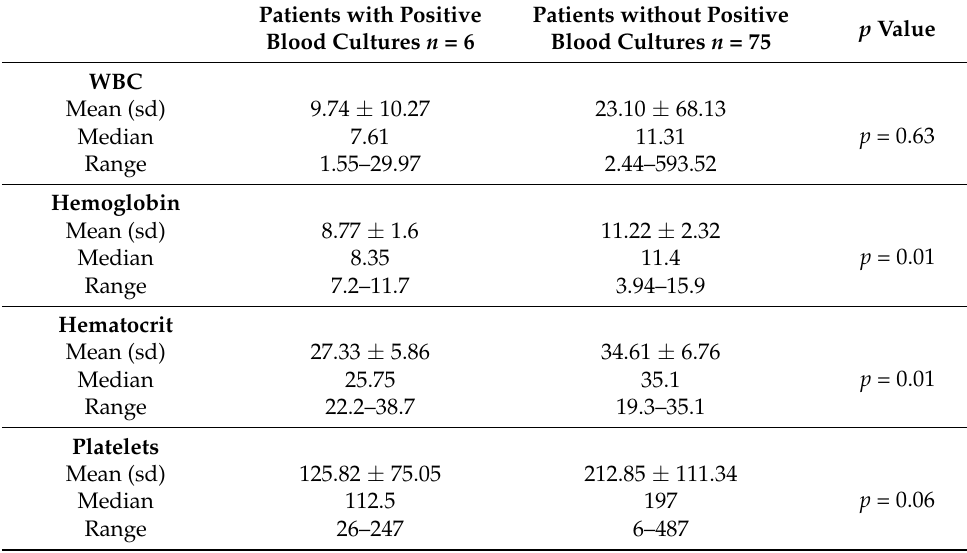
Table 4. Biomarkers statistics for non-tunneled